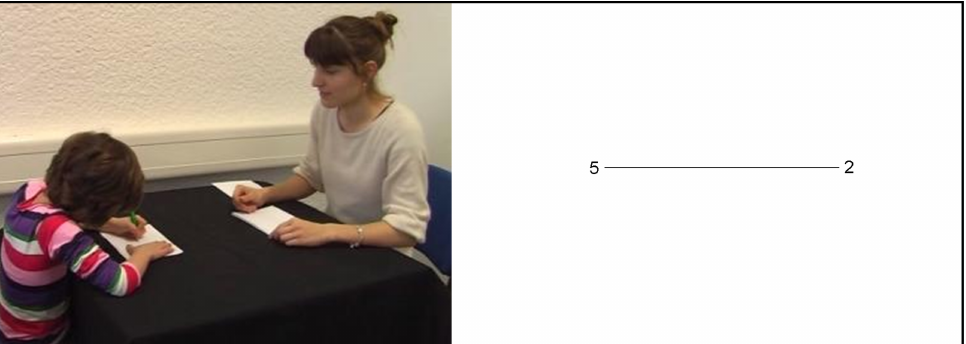
Figure 1. Left panel: Child and experimenter during the line bisection task (LBT). Right panel: Example of one sheet used in the